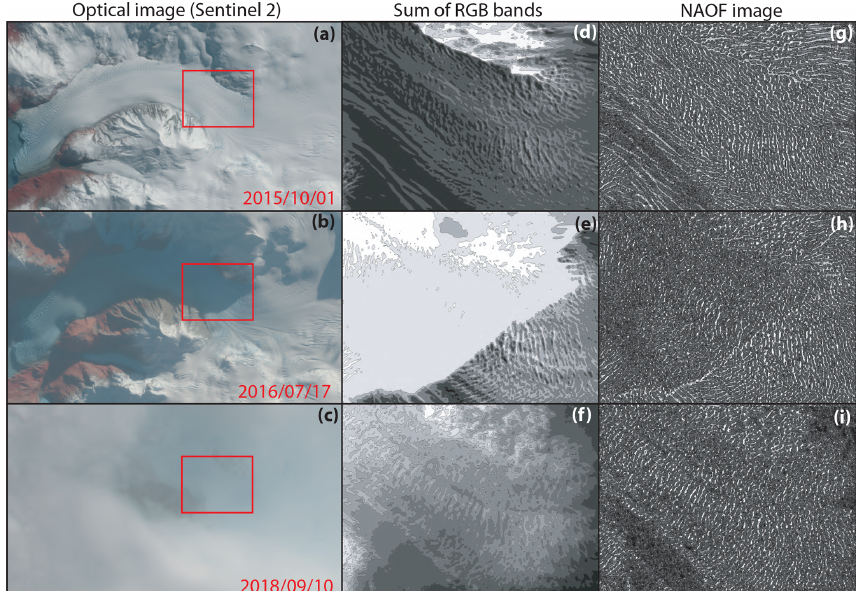
Figure 2. Comparison between raw optical images, band-summed images, and NAOF-filtered images for a clear image (a, d, g) , a heavily shadowed image (b, e, h) , and a cloudy image (c, f, i) of Amalia glacier, Patagonia ( − 50.92 ◦ S, − 73.56 ◦ W). Note how despite the complexity, the NAOF images recover a clear and easily traceable feature pattern on the surface of the glacier that is suitable for obtaining velocities. The shadow line leaves an artefact in (h) but is a marked improvement on the lack of features in the shaded area in (e) . Images from